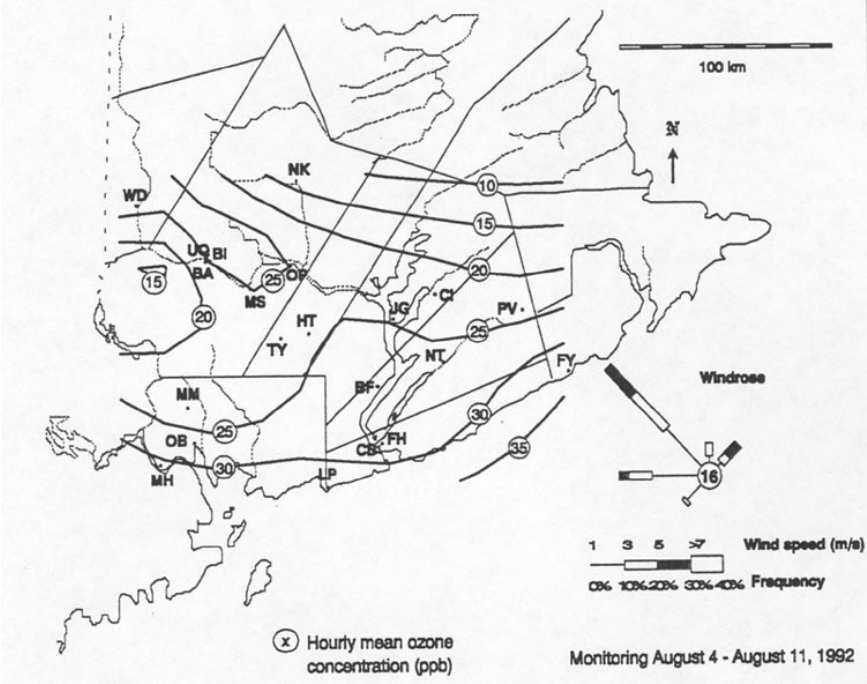
FIGURE 7. Contour map of ozone exposure measured with CanOxy Plate passive samplers in the canopy of white ash and black cherry in central and southern New Brunswick with major wind vectors from the